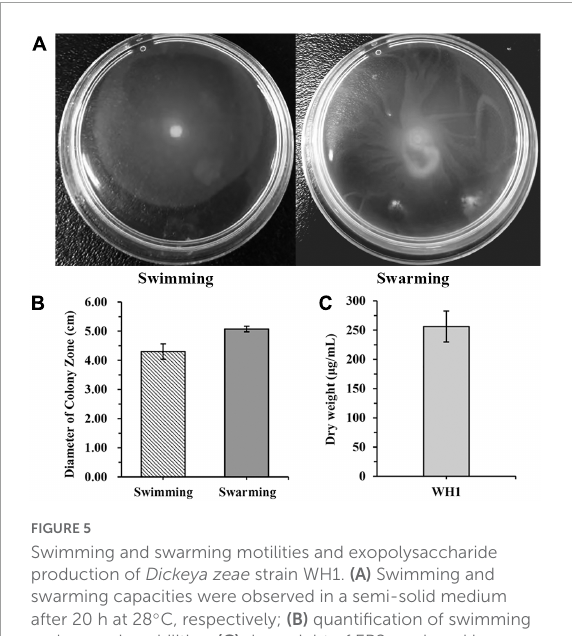
FIGURE5 Swimming and swarming motilities and exopolysaccharide production of Dickeya zeae strain WH1. (A) Swimming and swarming capacities were observed in a semi-solid medium after 20 h at 28 ◦ C, respectively; (B) quantification of swimming and swarming abilities; (C) dry weight of EPS produced